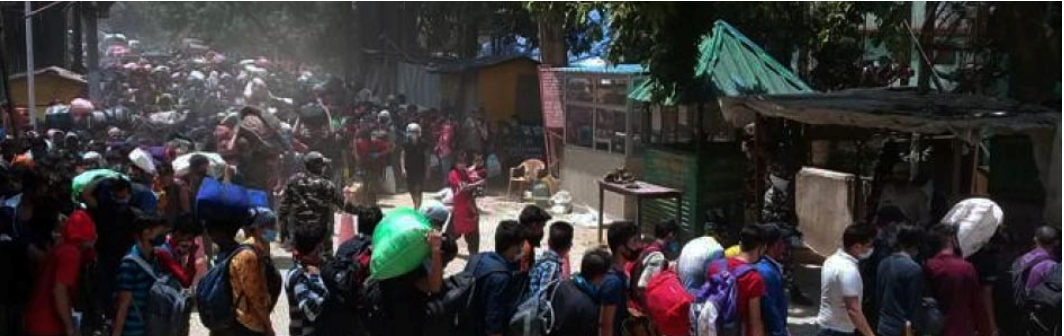
Figure 2. After the outbreak of COVID-19, both India and Nepal had enforced lockdown. These blue-collar Nepali workers are forced to leave their jobs in India without any alternatives. Currently, they are rushing to enter Nepal. This is just one example (Photo courtesy: